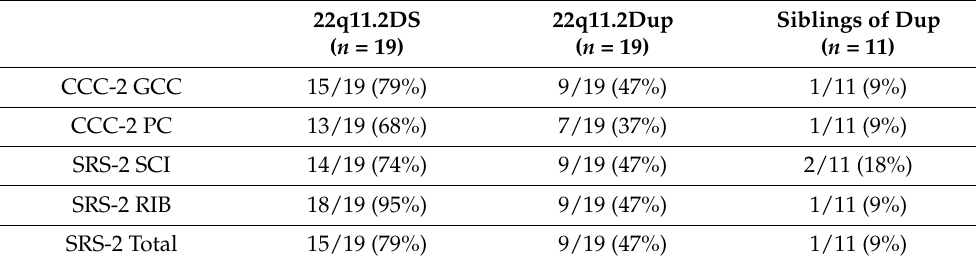
Table 3. Proportions of children with reported difficulties across composite scores on CCC-2 and